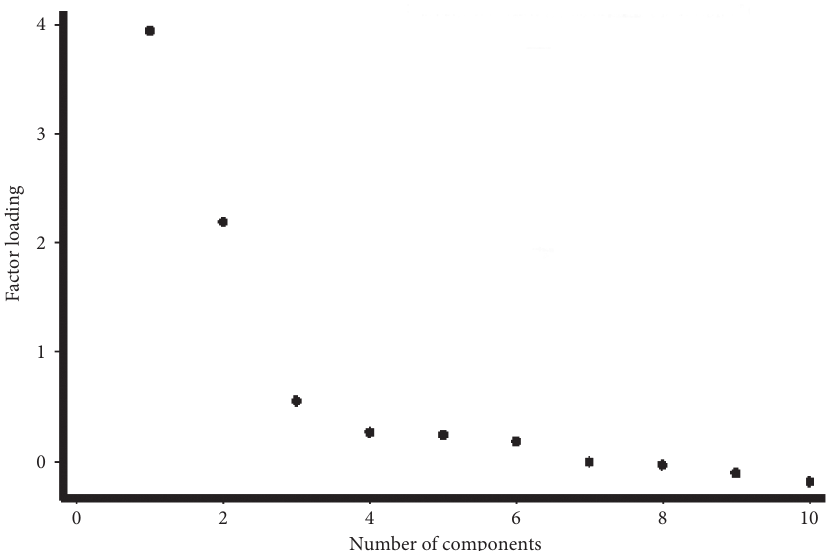
Figure 3: Screenplot showing the two-factor structure of the Beliefs about Medications